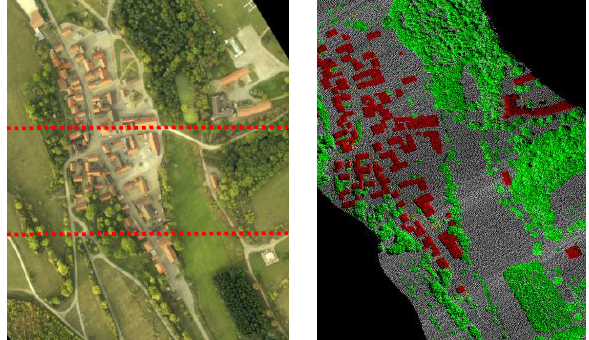
Fig. 3: (a) Aerial image of scene consisting of three parts North , Middle , and South. (b) Ground Truth of LiDAR point cloud (grey = ground , red = building , green = vegetation ).